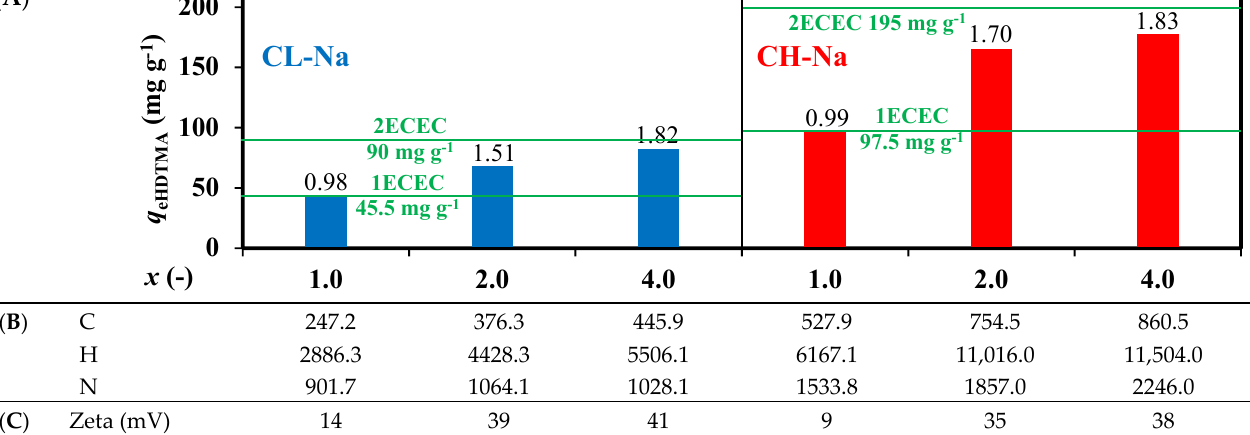
Figure 4. ( A ) Impact of HDTMA mass on efficiency of zeolite. DC values over the bars, ( B ) CHN analysis (mg 100 g − 1 of the SMZ), ( C ) Zeta potential. Q = 4 mL min − 1 , C 0 HDTMA = 1050 mg L − 1 , T = 40 °C.